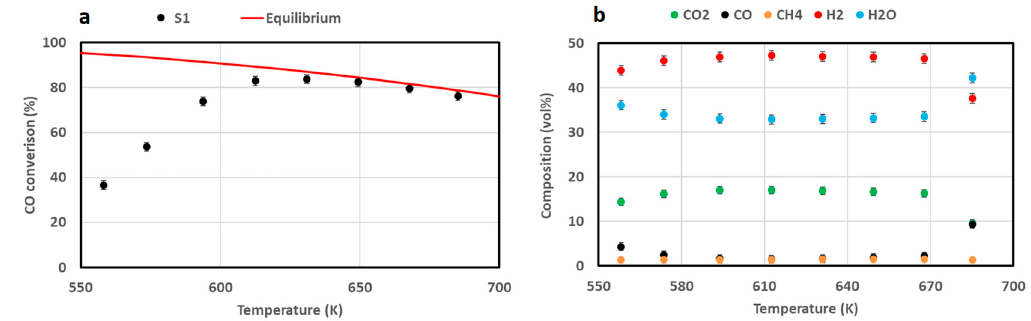
Figure 11. CO conversion ( a ) and product gas distribution as a function of reaction temperature ( b ) for S1 catalyst under a simulated reformate gas (37.61 vol% H 2 , 9.31 vol% CO 2 , 9.31 vol% CO, 42.19 vol% H 2 O, 1.37 vol% CH 4 ), τ = 53 ms.